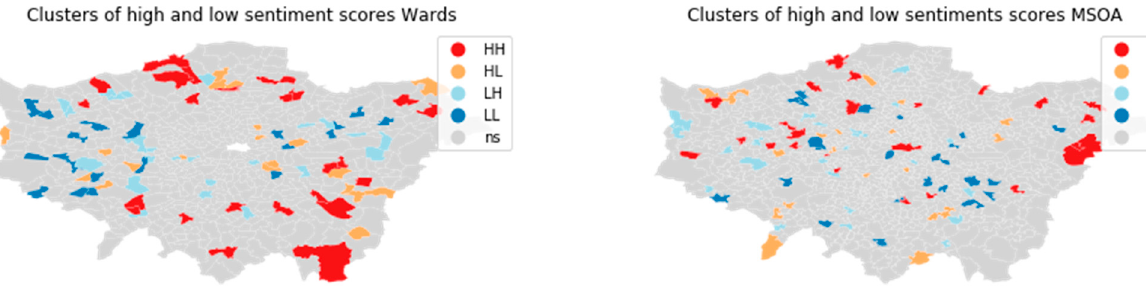
Figure 4. Comparison of spatial clusters (local Moran’s I, p < 0.05) of sentiment scores for wards and MSOA .